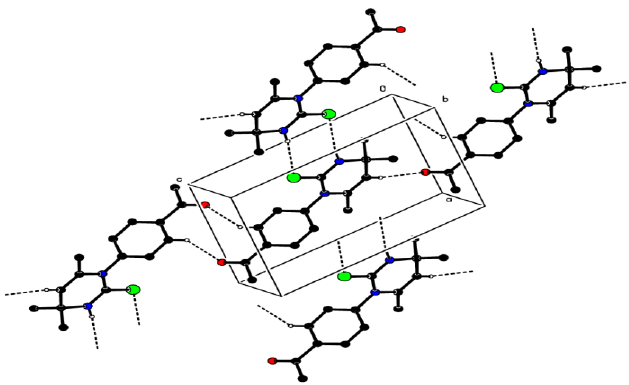
mental values and all are found within the normal range [25,26]. The X-ray diffraction data revealed that compound crystallizes in triclinic system. The unit cells dimensions